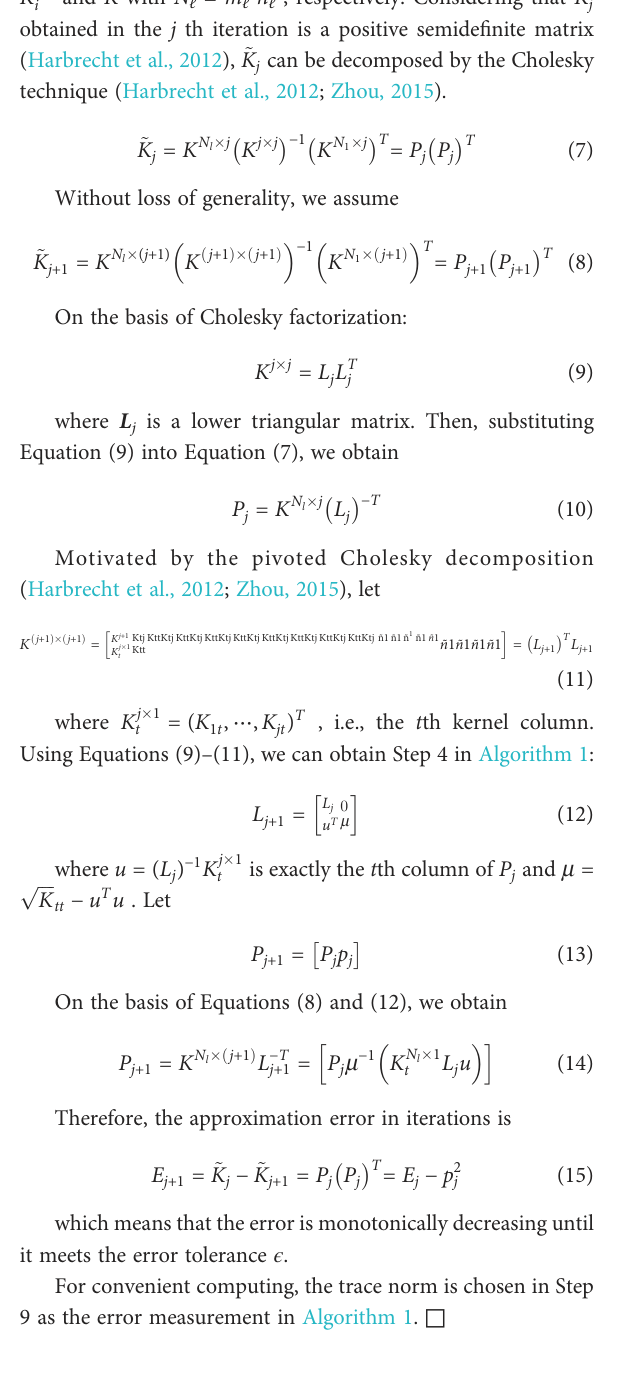
the Algorithm 1 satis fi es ‖ E ( ‘ ) denotes a minimum